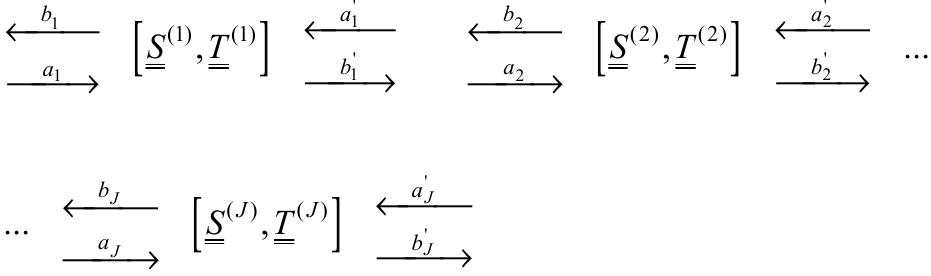
Figure 1. Flat periodic antenna structure infinite in the ( x , y ) plane, multilayer structure. The periodic flat antenna structure is shown in Figure 1. The geometry of a single antenna element remains arbitrary. The distance between the individual antenna elements in the x and y directions is d x and d y , respectively. The inclination angles of the symmetry axis of the antenna structure with respect to the x axis are respectively 0 and 𝛺 = 90 (cid:2868) − 𝛩 . Let us assume that the designations of the multi-layer antenna system are shown in Figure 2.